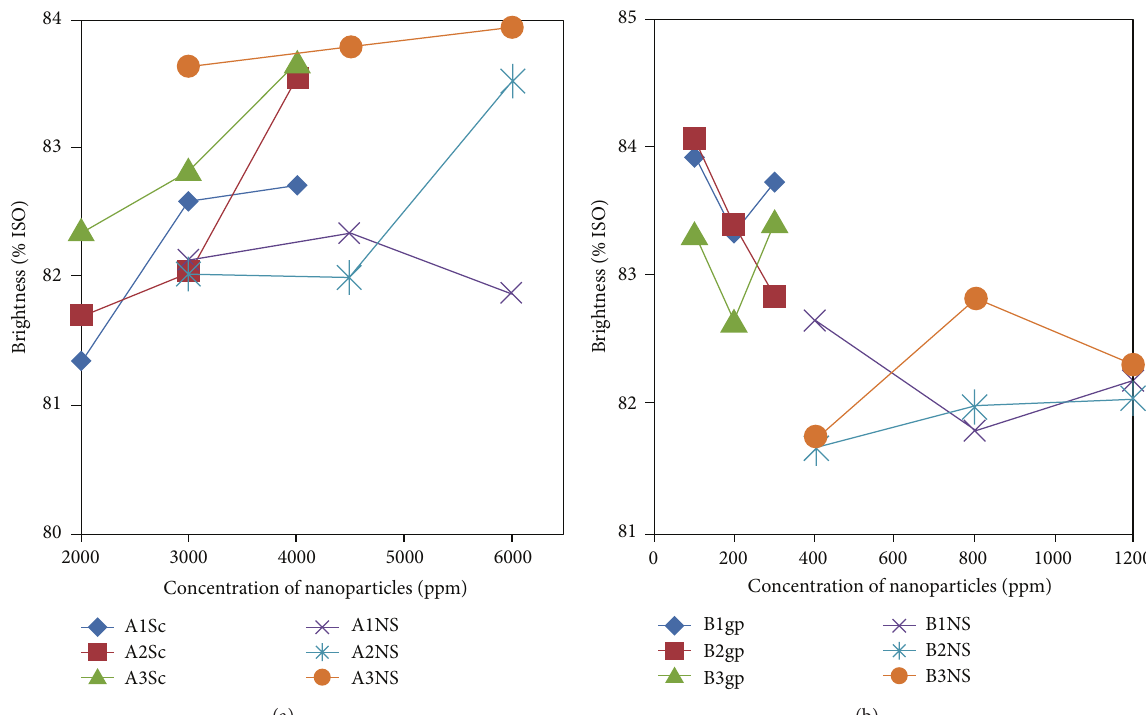
Figure 7: Effects of substituting NS for (a) Sc and (b) gp on the handsheet